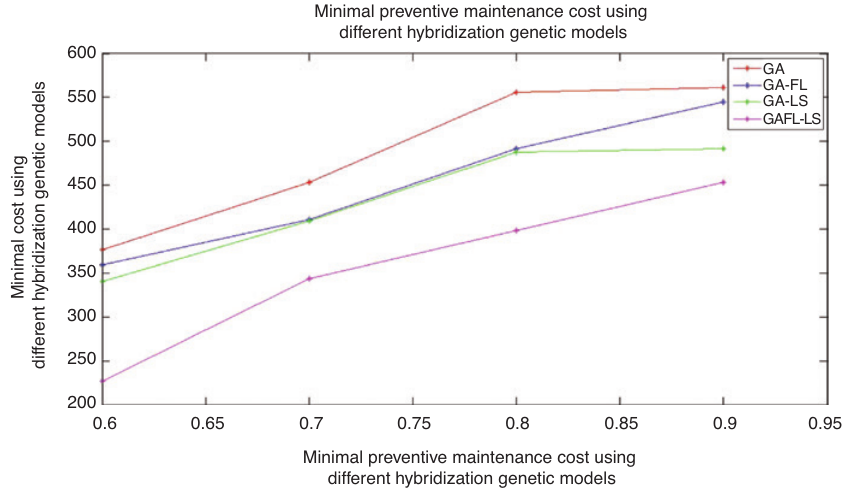
Figure 4: Minimal Preventive Cost for GA, FLC-GA, FL-GA, and FL-LS